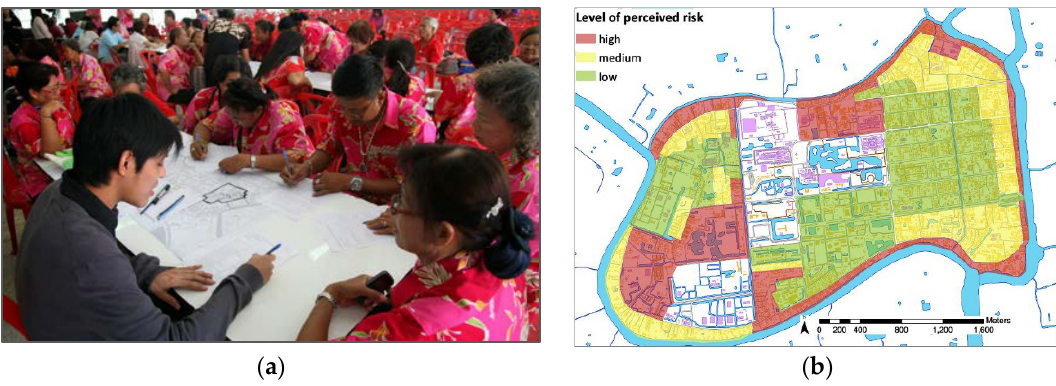
Figure 11. ( a ) stakeholder consultations and ( b ) illustration of the composite risk perception map, based on stakeholders’ inputs [48].